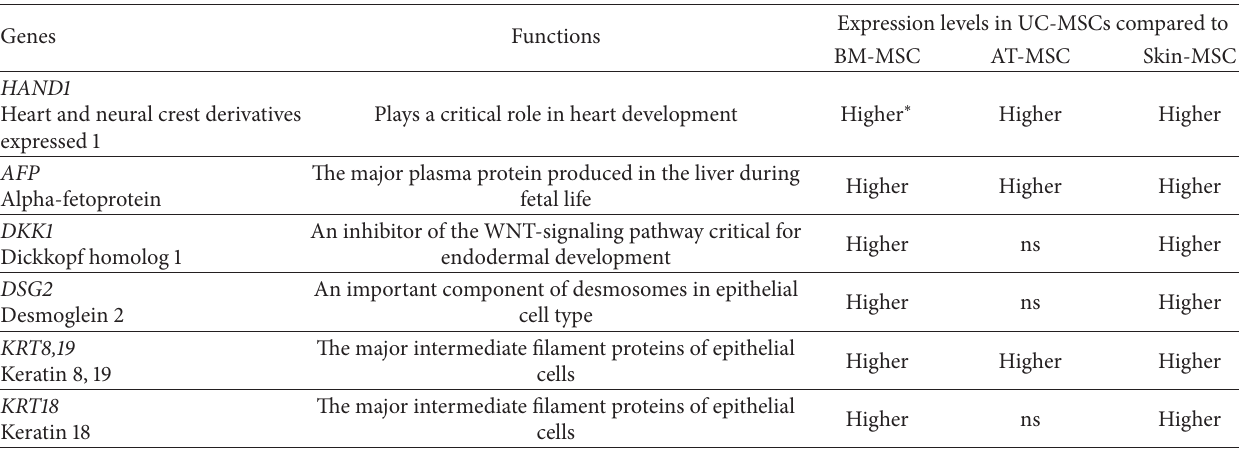
Table 3: The genes expressed at higher levels in UC-MSCs compared to MSCs derived from adipose tissue, bone marrow, and skin (according to